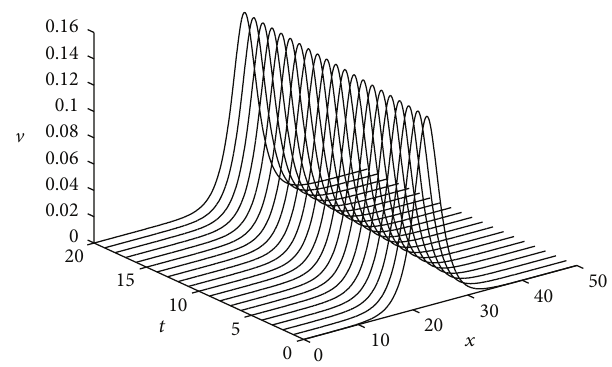
Figure 2: Single soliton 𝑉 : 𝑎 = −0.125 , 𝑏 = −3.0 , and 𝜆 = 0.5 .